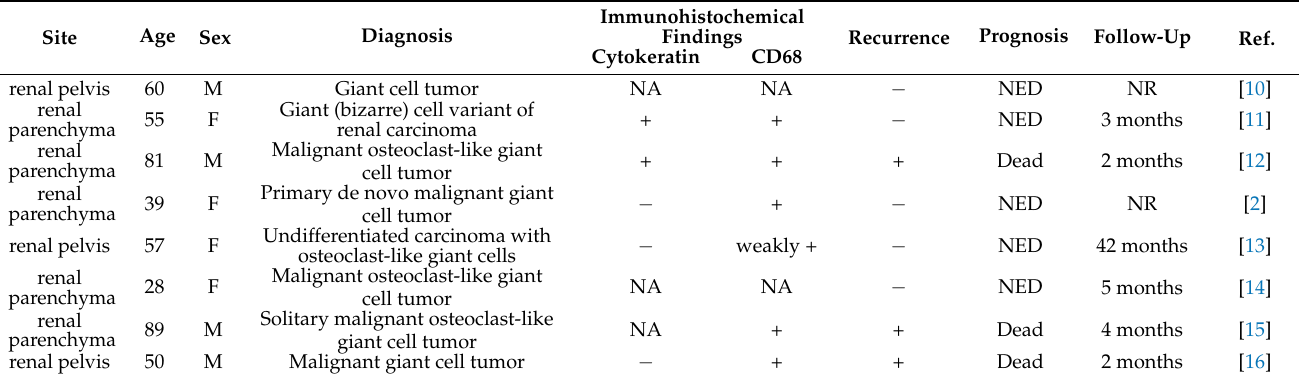
Table 3. Previous cases of giant cell tumor of the kidney without conventional carcinoma or sar- coma